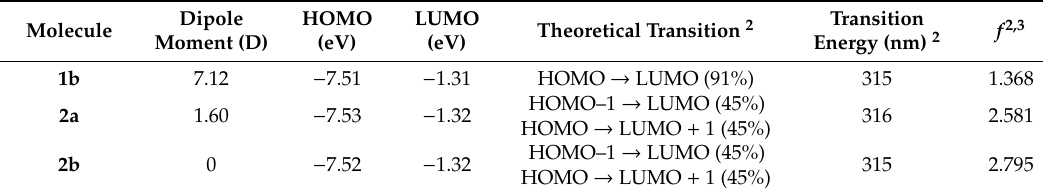
Table 1. Theoretical parameters of 1b , 2a , and 2b obtained by DFT calculations. 1